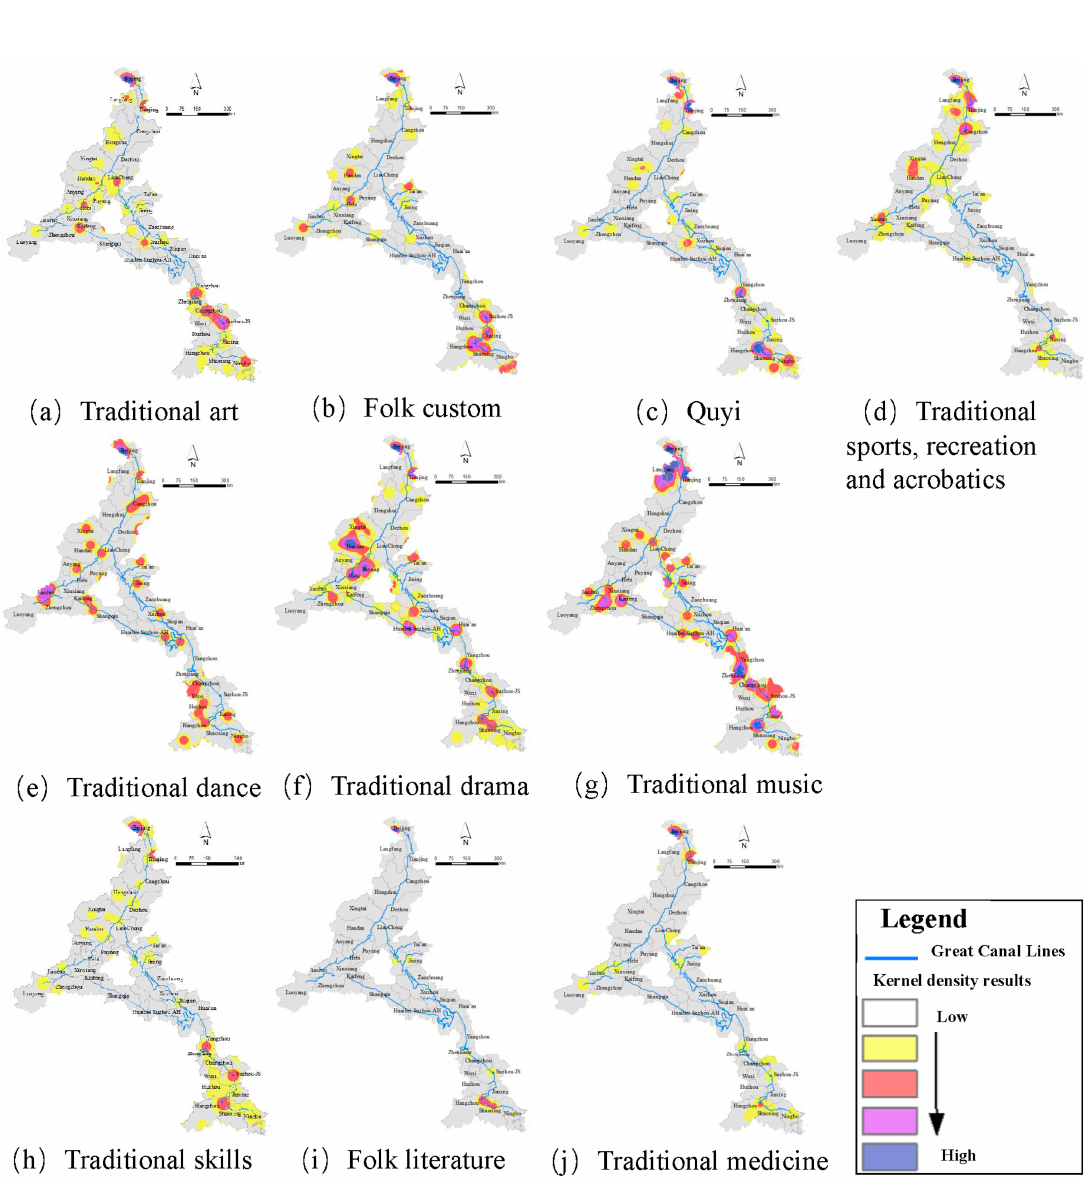
Figure 6. Kernel density of intangible cultural heritage (ICH) with different